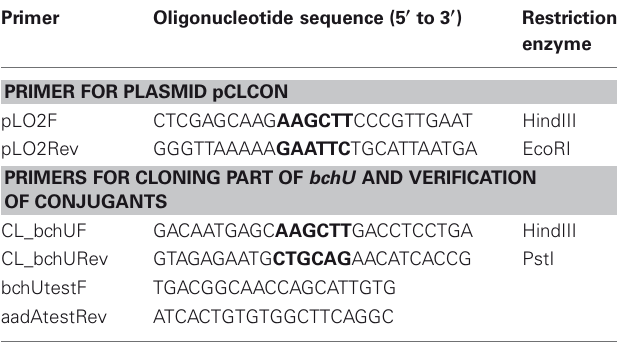
Table 1 | Oligonucleotide primers a . Primer Oligonucleotide sequence (5 (cid:2) to 3 (cid:2) )